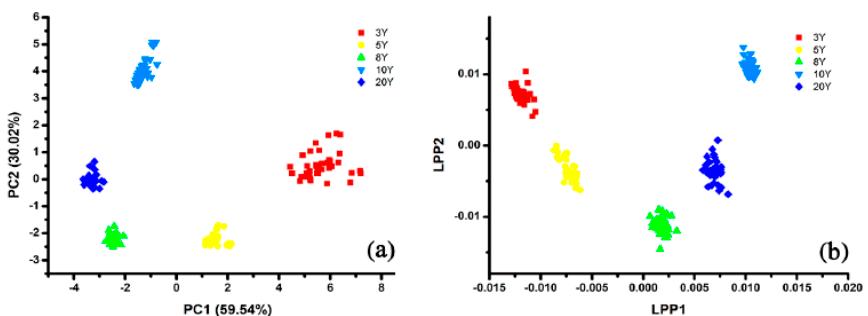
Figure 4. PCA scores plot ( a ) and locality preserving projections (LPP) ( b ) plots of rice wine samples with different ages (3, 5, 8, 10, and 20 years (Y)) based on original feature data for ET [58].